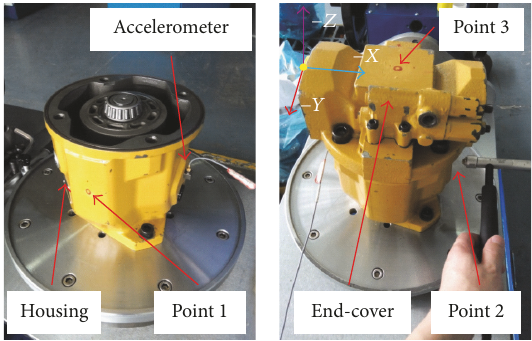
Figure 9: Experimental apparatus used to measure the natural frequencies of the pump.